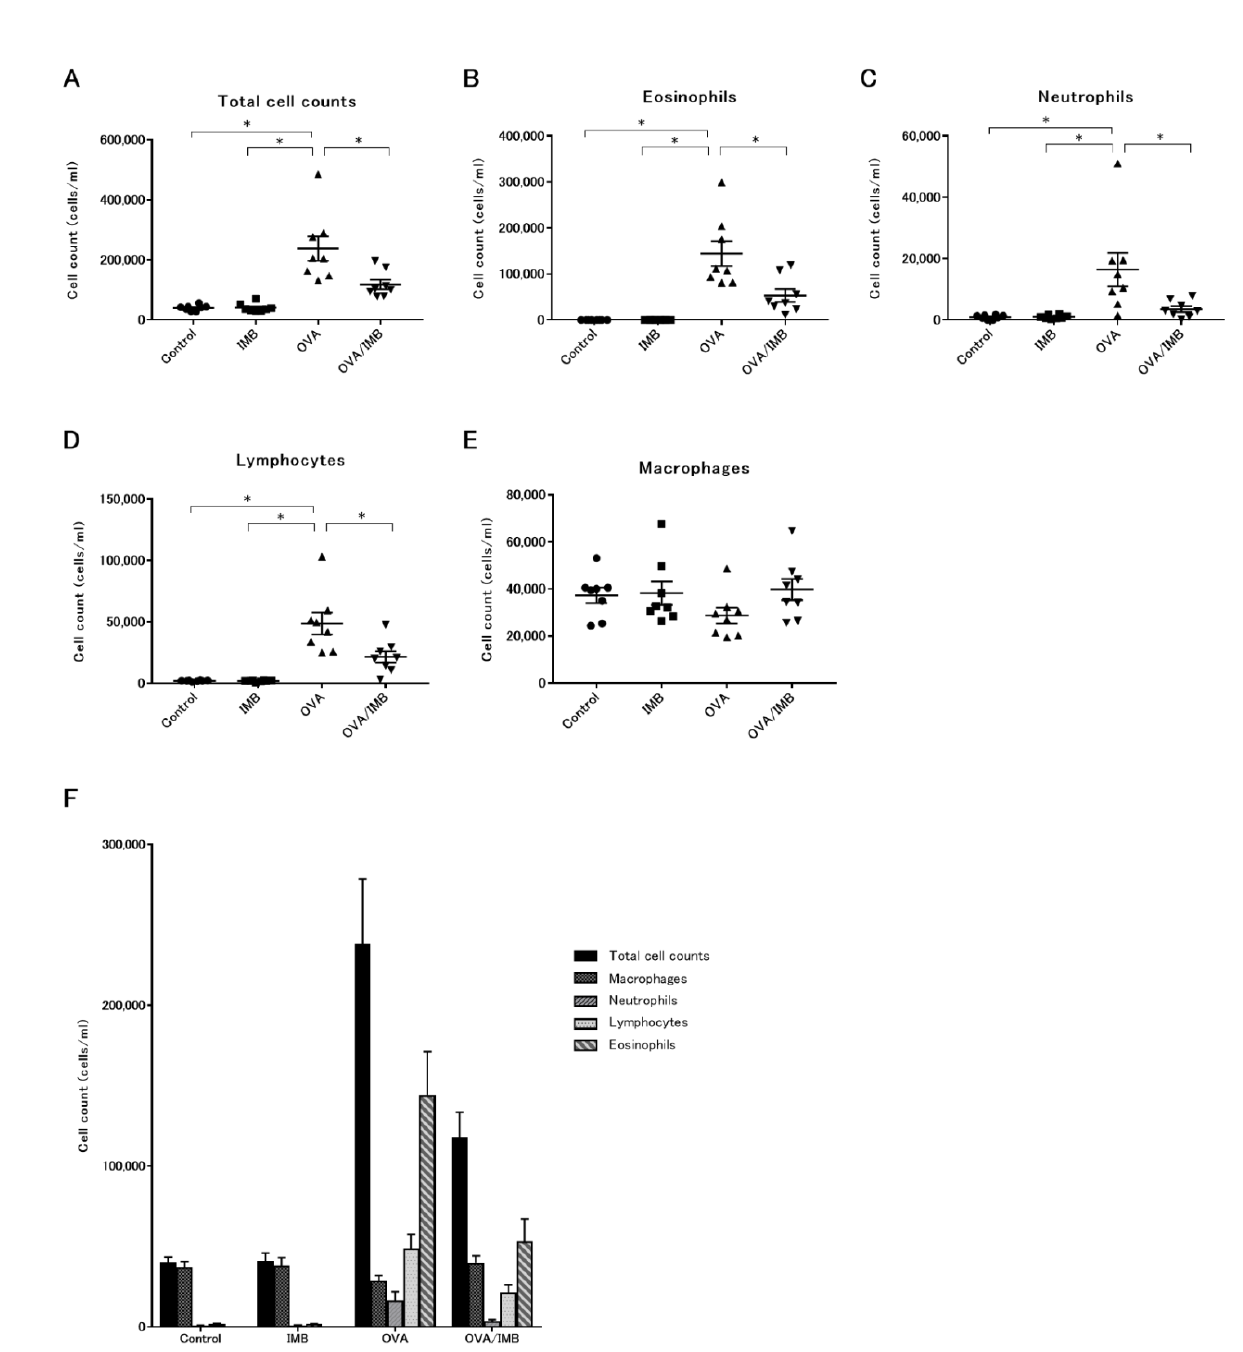
Figure 4. The total cell count and the number of eosinophils, neutrophils, and lymphocytes in BALF were significantly lower in the OVA/IMB group than in the OVA group, whereas the number of macrophages did not decrease. The numbers of total cells ( A ), eosinophils ( B ), neutrophils ( C ), lymphocytes ( D ), and macrophages ( E ). The cell fractions in each group ( F ). Values represent the mean ± standard error of the mean. * p < 0.05.